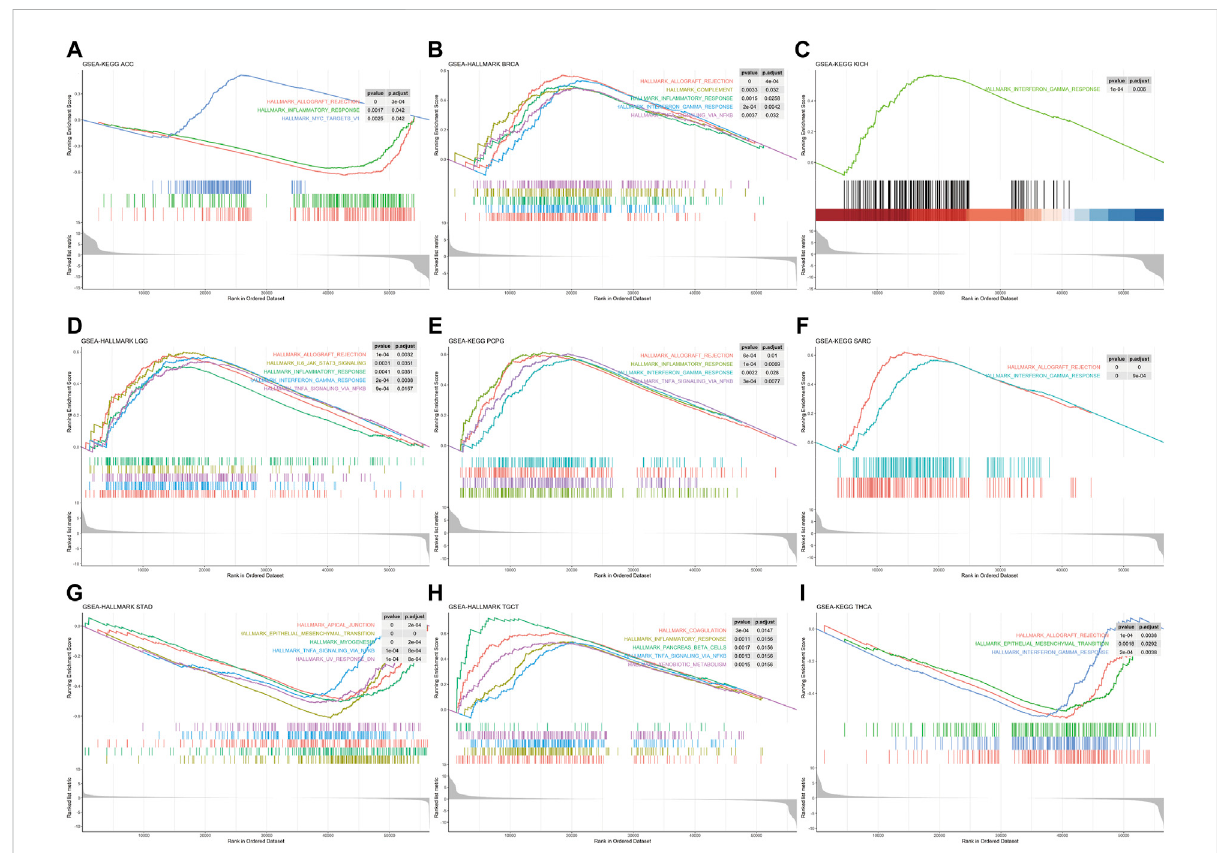
FIGURE 5 GenesetenrichmentanalysisofFDX1inPan-cancer. HALLMARK enrichmentresultsassociatedwith FDX1expression (A) ACC (B) BRCA (C) KICH (D) LGG (E) PCPG (F) SARC (G) STAD (H) TGCT (I) THCA. The X -axis represents the sequencing of expression values of genes enriched in different pathways within the sample, and the Y -axis represents the enrichment